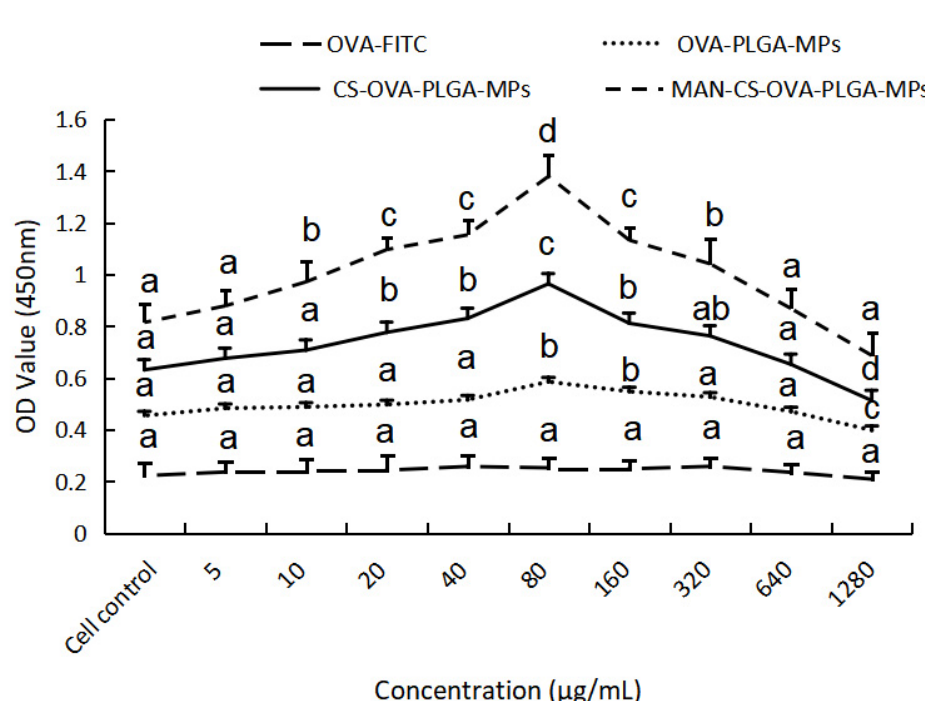
Figure 4. Effect of MAN-CS-OVA-PLGA-MPs on the activity of DCs. Macrophage cell activity was measured using the CCK-8 method. Results are presented as mean ± SD ( n = 6). Significant differences are indicated with different letters ( p < 0.05).